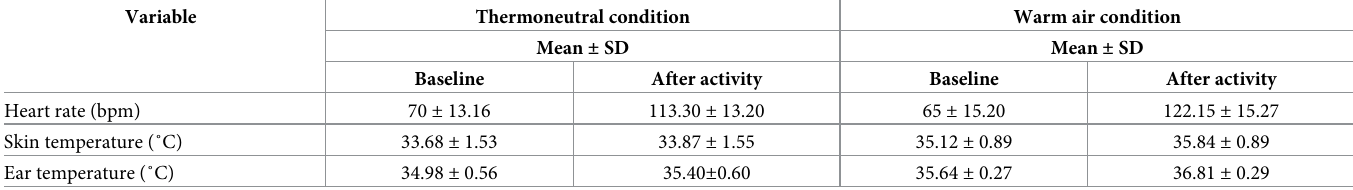
Table 2. Participants’ physiological responses before and after walking on a treadmill in thermoneutral and warm conditions. Variable